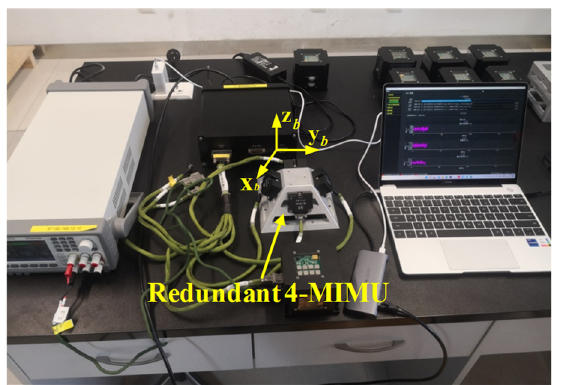
Figure 20. The conical configuration of a 4-MIMU system on the tetrahedral pyramid. Table 7. Cross-correlation matrix for a redundant 4-MIMU system.